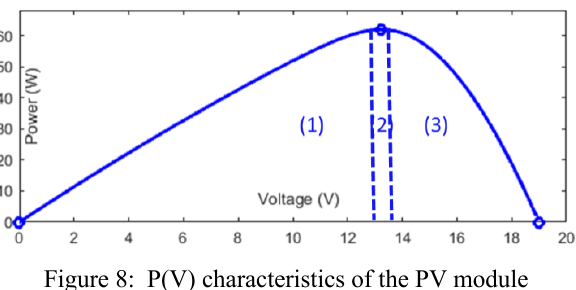
Figure 8: P(V) characteristics of the PV module